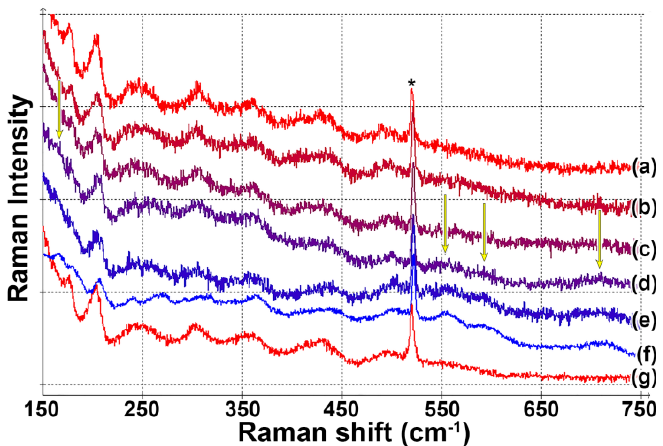
Figure 5. Raman spectra of V 4 O 7 at different temperatures: ( a ) 20 °C, ( b ) –40 °C, ( c ) –50 °C, ( d ) –55 °C, ( e ) –60 °C, ( f ) –75 °C, ( g ) 20 °C after low-temperature measurements. The asterisk marks the position of the Si substrate peak. Arrows mark the appearance of new peaks indicating the phase transition.